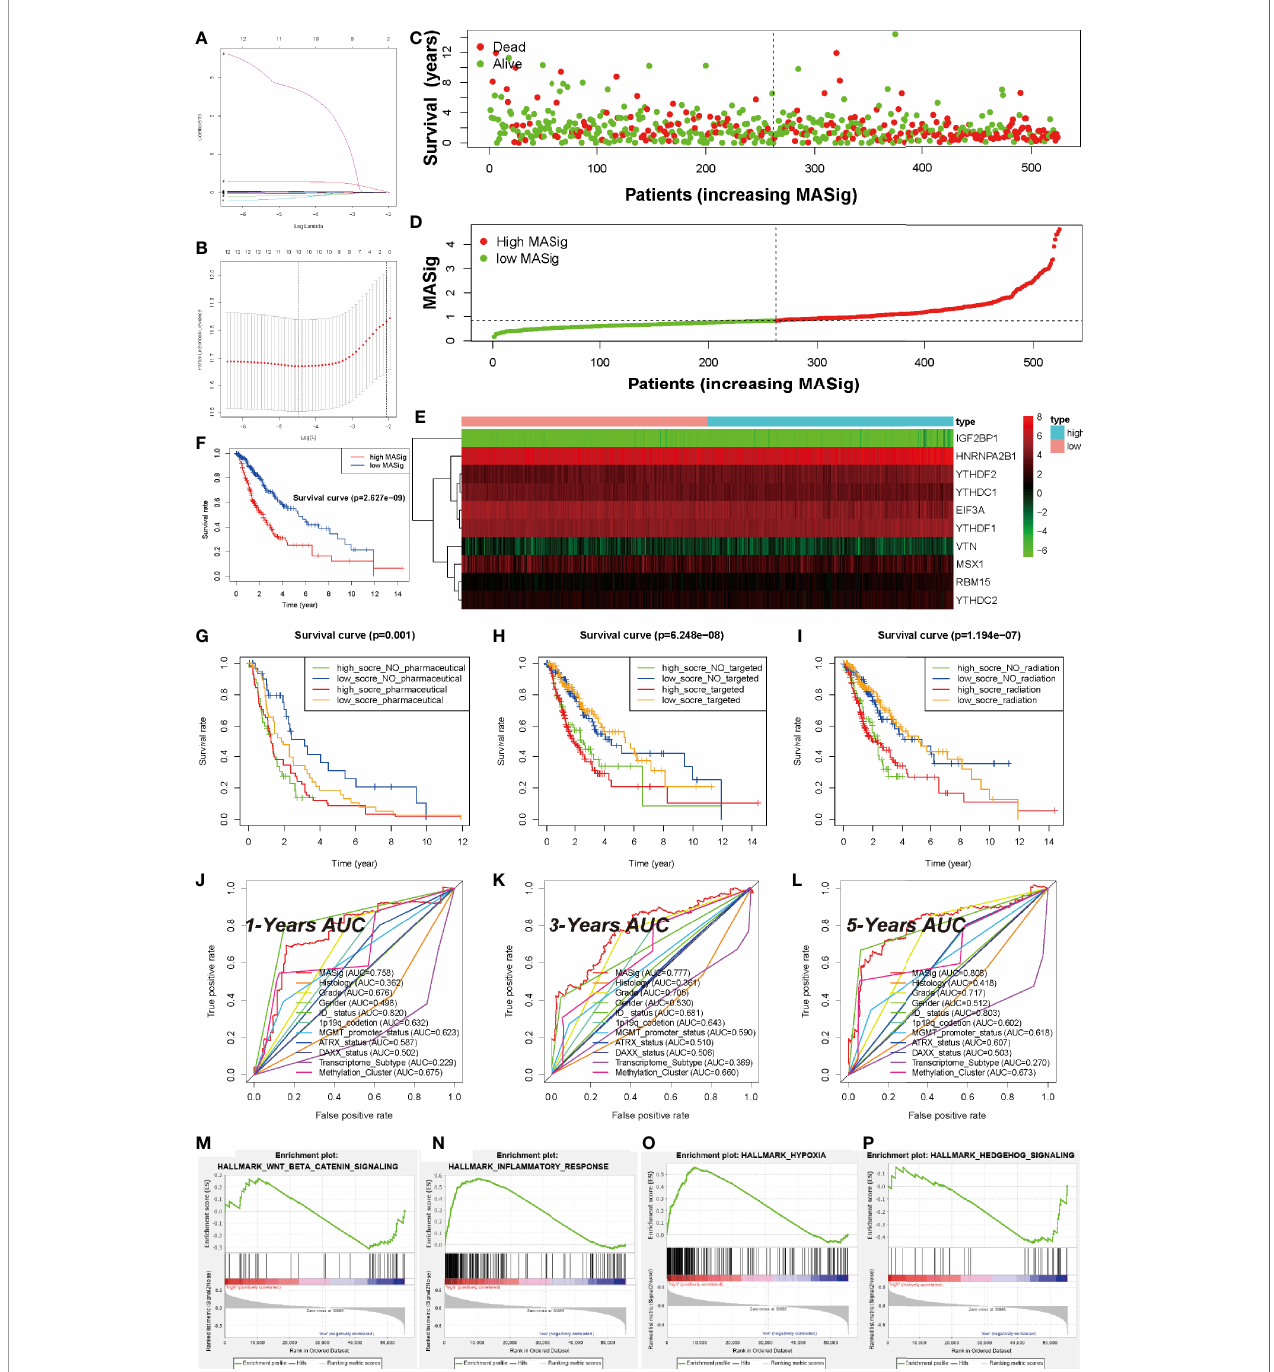
FIGURE 5 | Prognostic Value of MAGs in LGG. (A) Ten-time cross-validation for tuning parameter selection in the TCGA-LGG cohort. (B) Regression coef fi cient pro fi les of identi fi ed m6A regulators in the TCGA-LGG cohort. (C) The distribution of survival status of MASig. (D) The distribution of MASig (high and low) of patients with LGG. (E) The correlation and distribution of hub MAGs expression values and MASig. (F) Survival analyses for low- and high- MASig groups in TCGA-LGG cohort using Kaplan – Meier in Log-rank test. (G – I) Survival analyses for subgroup patients strati fi ed by both MASig and treatment with pharmacological chemotherapy (G) , targeted therapy (H) , and radiotherapy (I) using Kaplan – Meier curves in the Log-rank test. (J – L) ROC curves with calculated area under the curve (AUC) for risk prediction in 1 (J) , 3 (K) , 5 (L) years in the TCGA-LGG cohort. (M – P) GSEA revealed that genes with higher expression in the CL2 subgroup were enriched for hallmarks of malignant